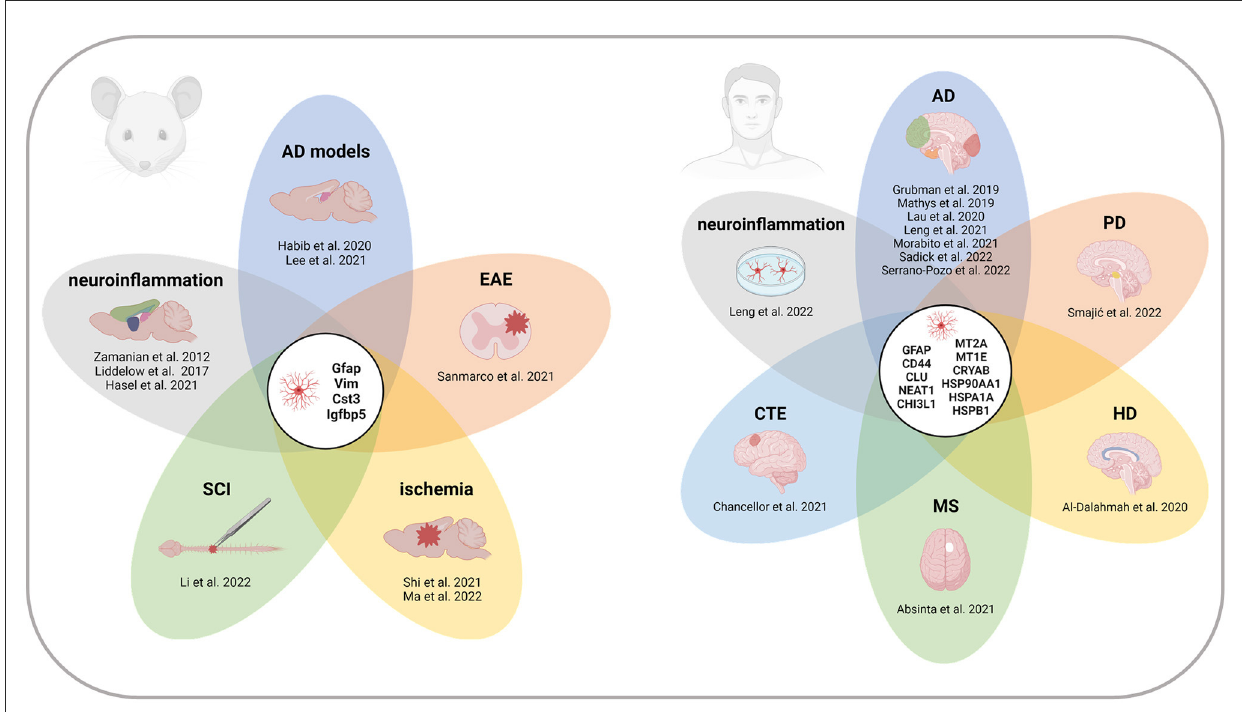
FIGURE1 Recurrent marker genes of reactive astrocytes across CNS regions and pathologies in mice and humans. Genes indicated in the centers of the diagrams appeared in at least four of the studies listed in Table 1. All the references report at least one of the recurrent genes. References without overlap are not included in the diagrams. Note that the gene signatures of individual reactive populations are not exhaustive, and therefore, the presented gene overlap cannot be generalized as a complete list of reactive astrocyte markers. AD, Alzheimer’s disease; CTE, chronic traumatic encephalopathy; EAE, experimental autoimmune encephalomyelitis; HD, Huntington’s disease; MS, multiple sclerosis; PD, Parkinson’s disease; SCI, spinal cord injury. Created with